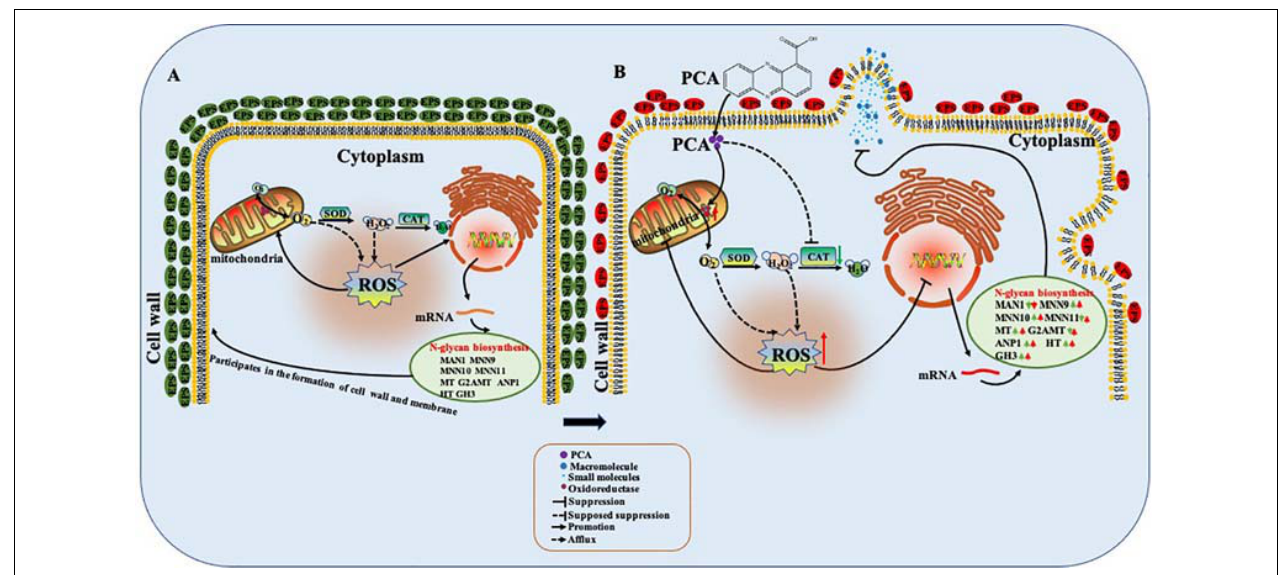
FIGURE 12 | Possible mode of action of phenazine-1-carboxylic acid (PCA) on Ps. camelliae-sinensis hyphae. When PCA entered into the hyphal cell, PCA changed oxidoreductase activity, decreased activity of catalase (CAT), and accumulated reactive oxygen species (ROS), so as to induce the deformity of hyphae and inhibit the growth of the hyphae. Meanwhile, PCA influenced the transcription in the pathway of N -glycan biosynthesis of hyphae and decreased the content of exopolysaccharides (EPS) on the hyphal surface. (A) The untreated hyphae; (B) The hyphae treated with